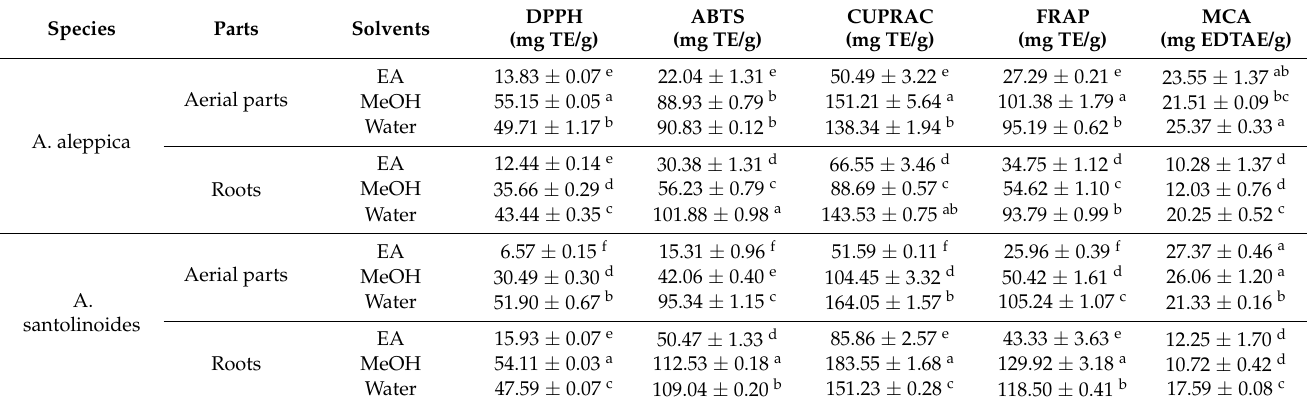
Table 3. Antioxidant properties of the tested extracts